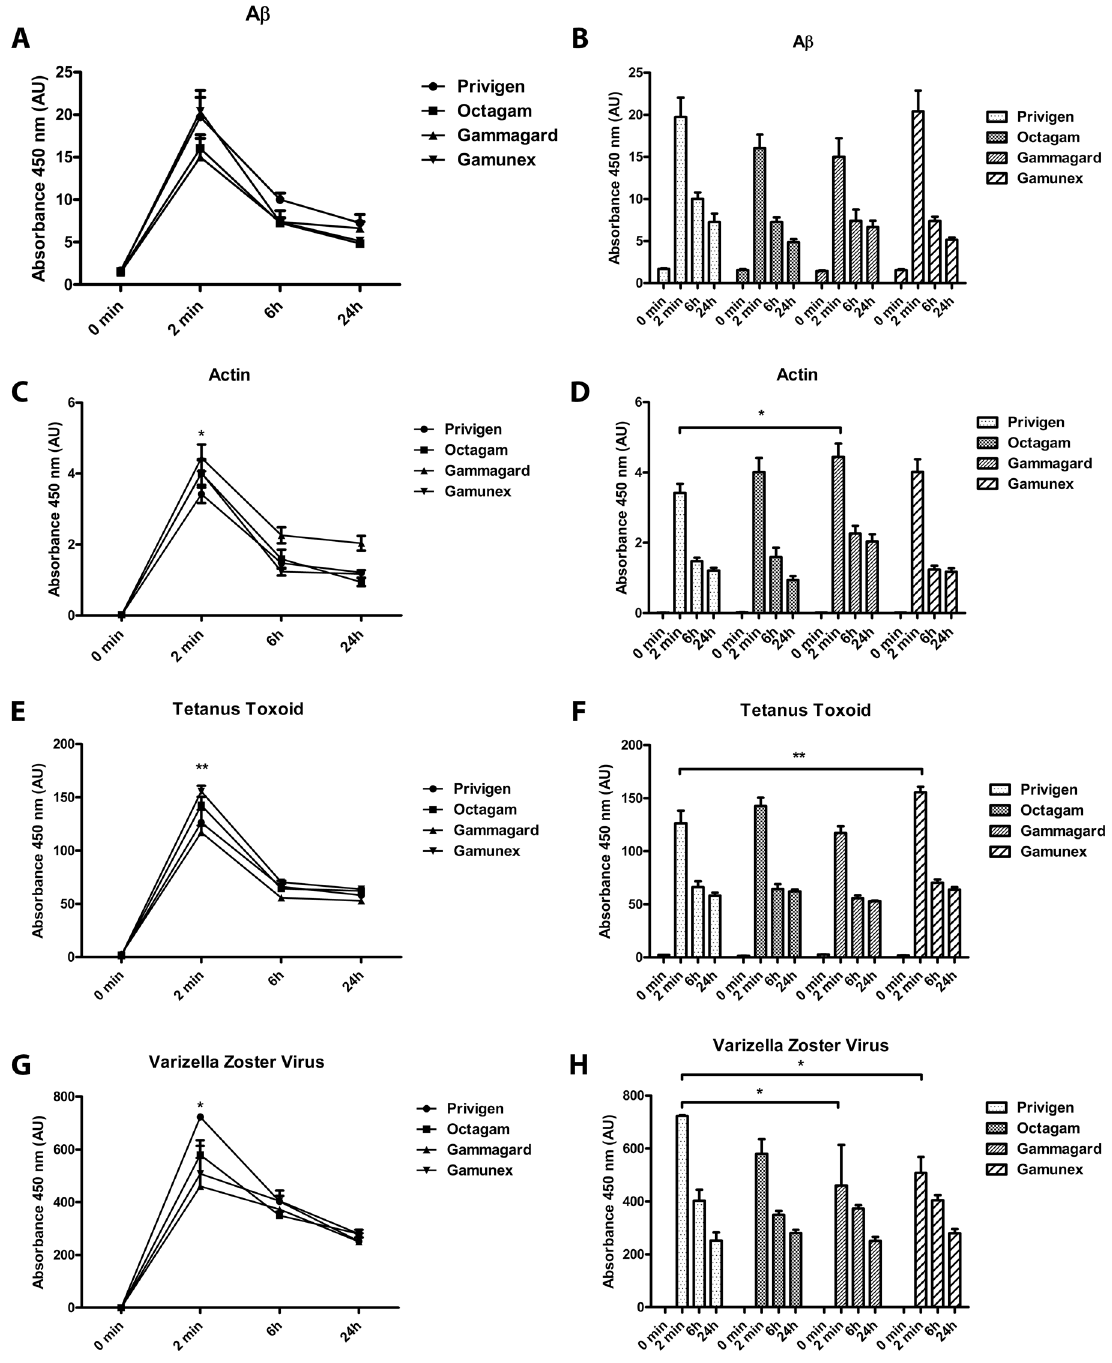
Fig 6. In vivo comparison of the binding to A β , Actin, tetanus toxoid and Varicella Zoster Virus by ELISA. Clr:CD(SD) rats (n = 10 in groups 0 min and 2 min; n = 5 in groups 6h and 24h) were intravenously injected with 500 mg/kg of Privigen 10%, Gammagard 10%, Octagam 10% or Gamunex 10%, respectively. Blood was taken at baseline (0 min) as well as 2 min, 6h and 24h after injection. Plasma (10% citrate) was prepared and the binding capacity to oligomeric A β (A and B), actin (C and D), Tetanus Toxoid (E and F), and VZV (G and H) was analyzed by ELISA. ( * p < 0.05, ** p < 0.01). Each ELISA was performed 3 times n = 3 (with all animals n = 30) except VZV t = 2 min n = 2 (with all animals n = 30) due to limited sample